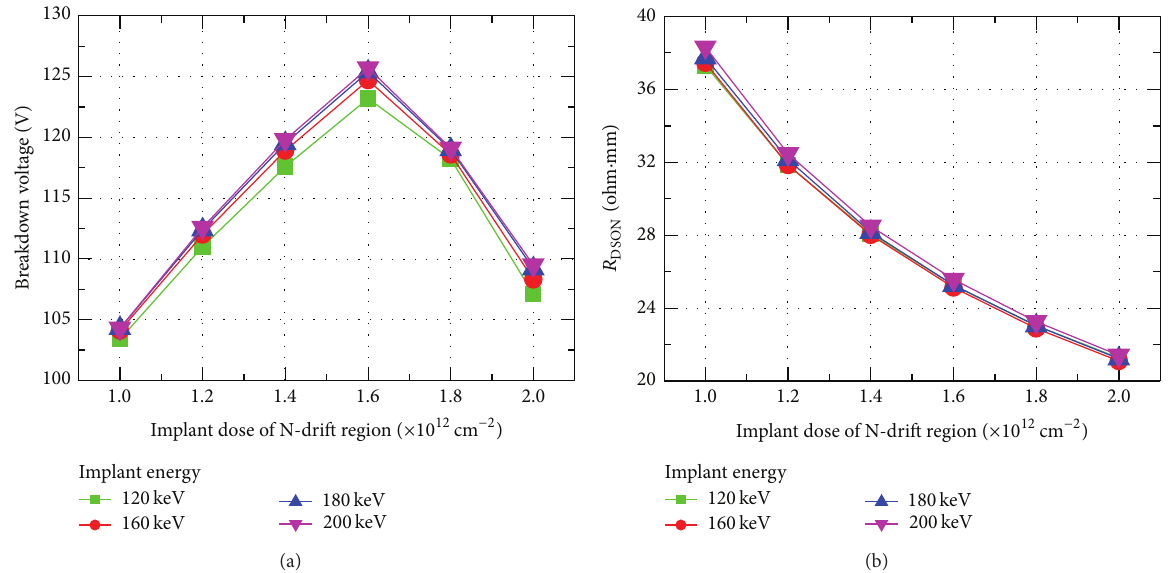
Figure 2: Relationship of the (a) breakdown voltage and (b) on-resistance ( 𝑅